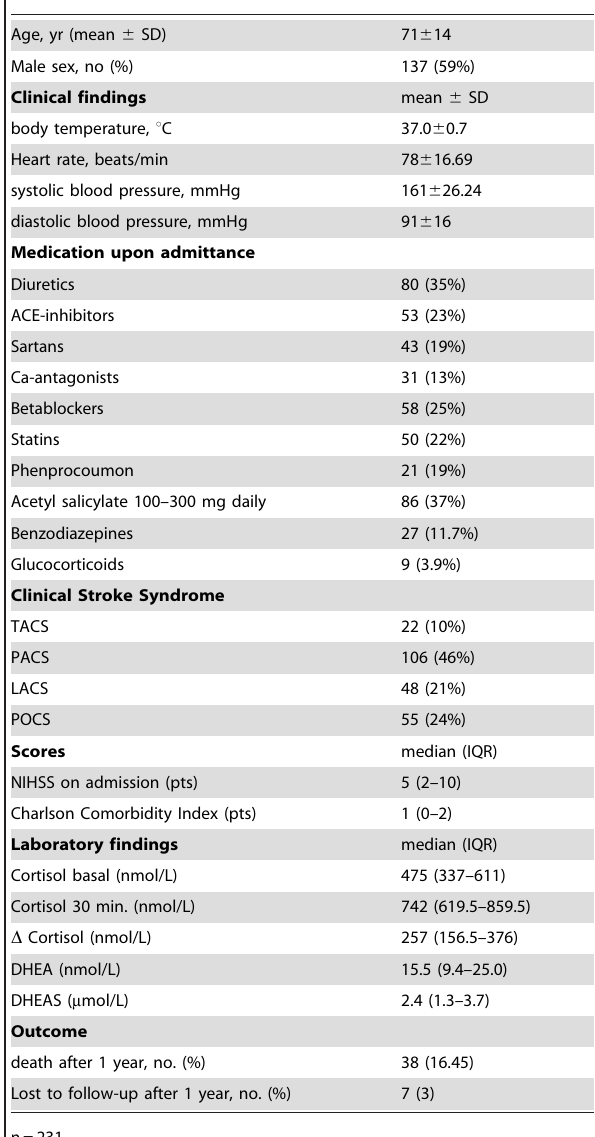
Table 1. Baseline